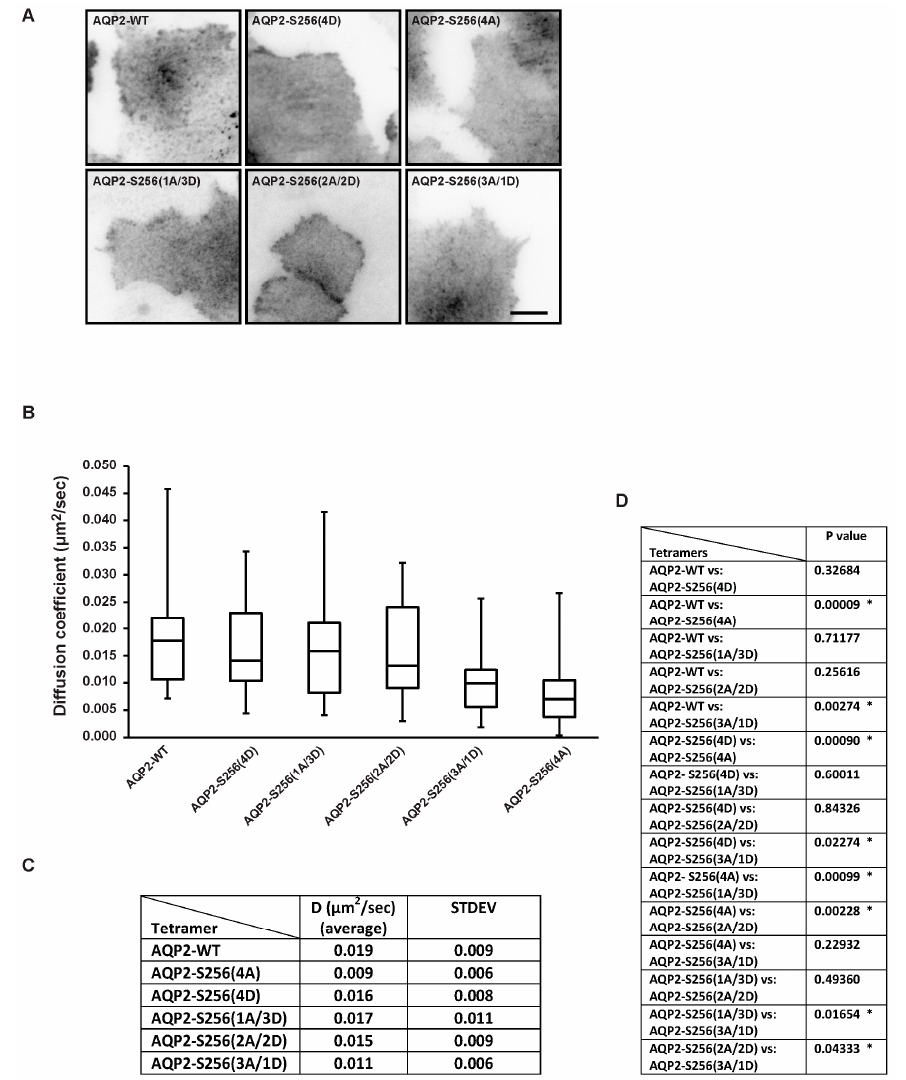
Figure 4. AQP2 diffusion coefficients change with respect to the degree of S256 phosphorylation. ( A ) Representative fluorescence images captured in Total Internal Reflection Fluorescence (TIRF) mode of MDCK cells transiently transfected with the indicated constructs. Fluorescence is shown in inverted contrast. Scale bar is 10 µ m; ( B ) k-space Image Correlation Spectroscopy (kICS) analysis of time-lapse image sequences of MDCK cells transiently transfected with untagged AQP2, AQP2-S256(4D), AQP2-S256(4A), AQP2-S256(1A/3D), AQP2-S256(2A/2D), and AQP2-S256(3A/1D). Diffusion coefficients are shown in a Box-and-whiskers plot; ( C ) table showing average diffusion coefficients and standard deviations (STDEV) for each combination of transfection combination; ( D ) table showing p -values. * indicates p < 0.05.